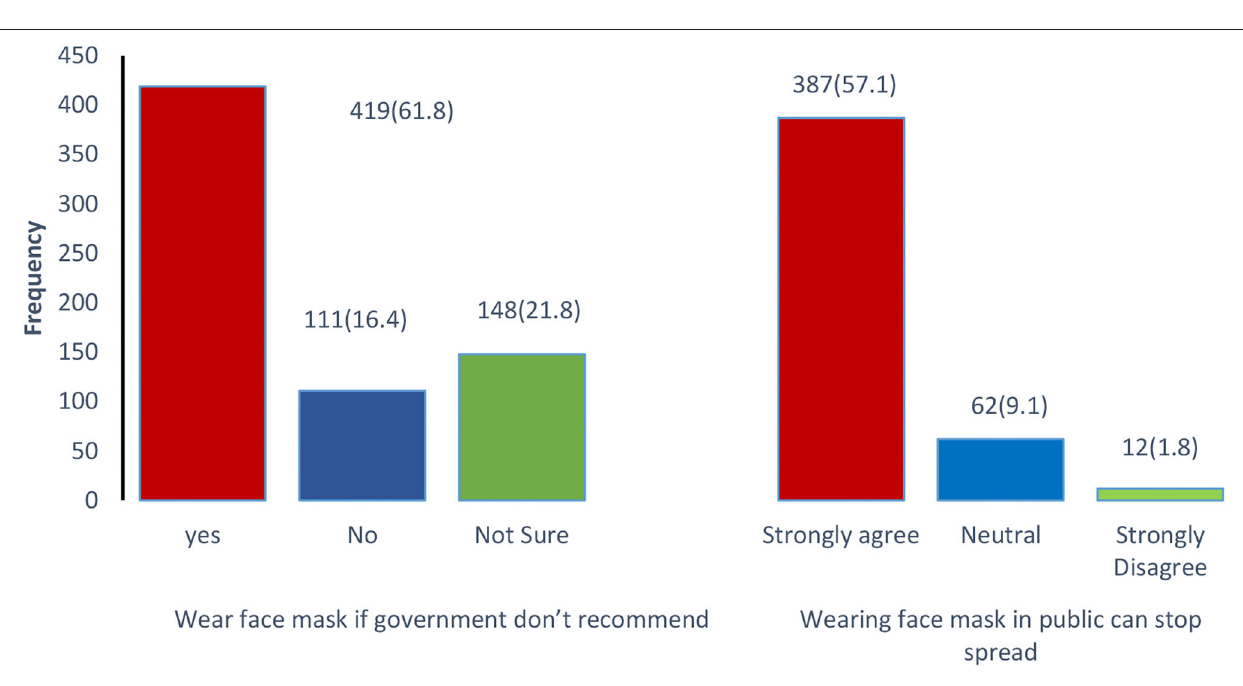
FIGURE 2 | Participant’s attitude toward using a face